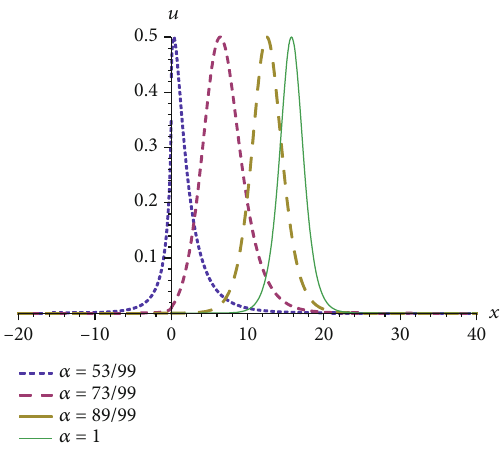
Figure 1: Pro fi les of fractional one-soliton u with di ff erent orders by selecting a = 0 , b = 2 , c = 3 , k 1 = 1 , p 1 = 1/2 , σ = 1 , ξ ð and t = 0